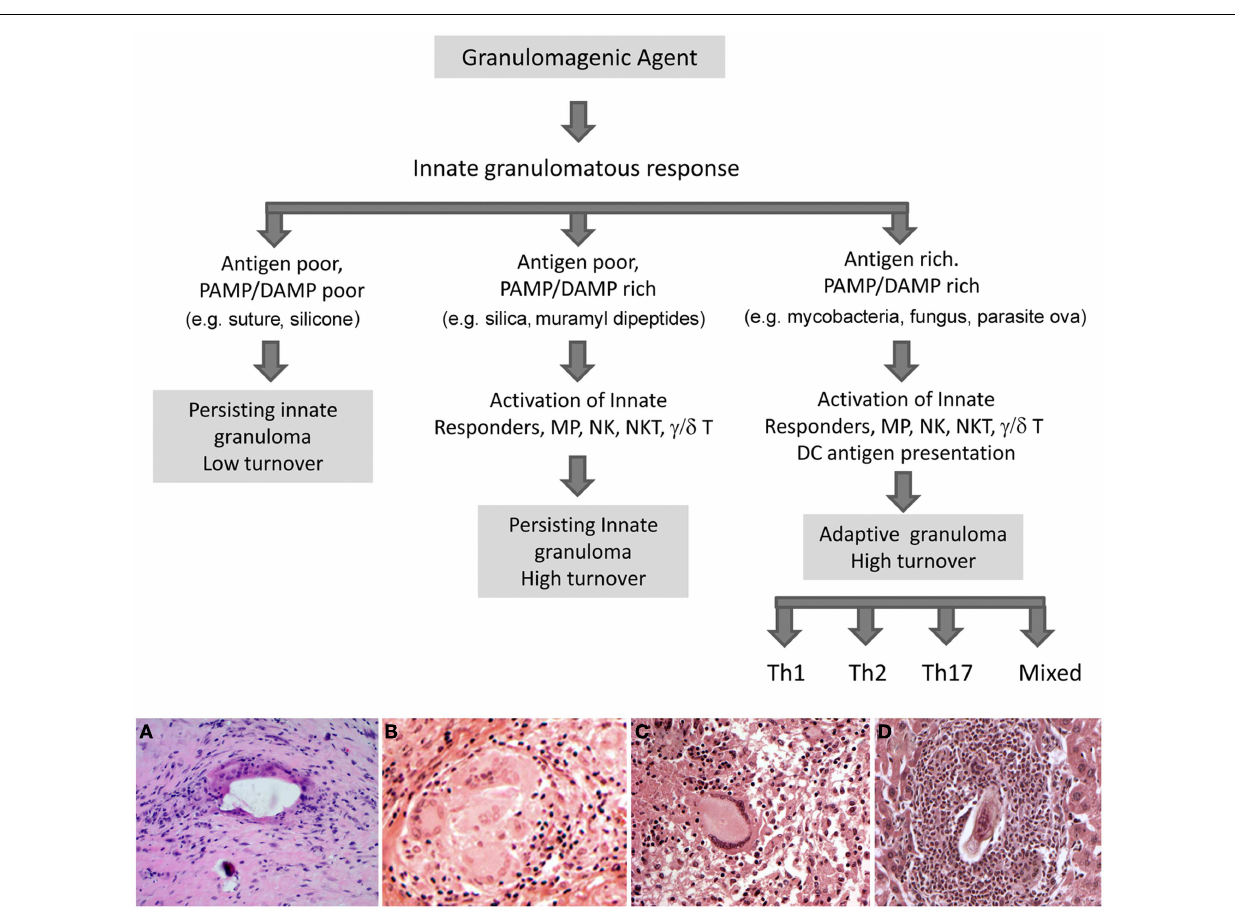
FIGURE 1 | Potential fates of the innate granuloma. In the immunocompetent host the ultimate type of granuloma manifested will depend in large part on the nature of the inciting agent.Weakly antigenic agents with poor expression of pathogen (PAMP) and or damage (DAMP) associated molecular patterns will result in a persisting low turnover innate granuloma. Examples would be surgical implant and suture granulomas. Weakly antigenic agents associated with greater PAMPs or DAMPs will activate a broader spectrum of innate responding cells resulting in more complex higher turnover innate granulomas. Examples would be silica, zymosan, and muramyl dipeptide induced granulomas. Strongly antigenic agents with associated PAMP or DAMP signals will initiate additional adaptive